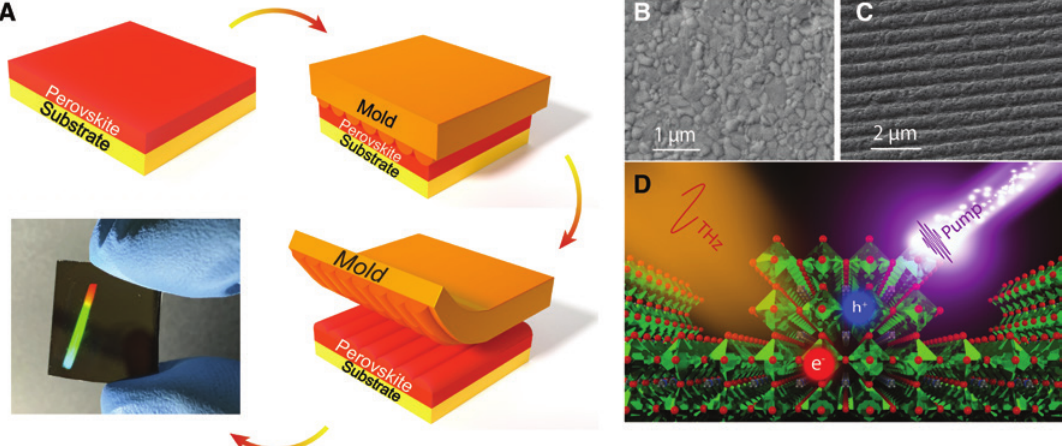
Figure 1: Samples and concept. (A) Technological steps for nanostructured MAPbI films fabrication by means of nanoimprint lithography (NIL). SEM images of a perovskite 3 film before (B) and after (C) NIL. (D) Schematic illustration of the principle of THz generation enhancement in the nanostructured perovskite film (upper) as compared with a smooth film